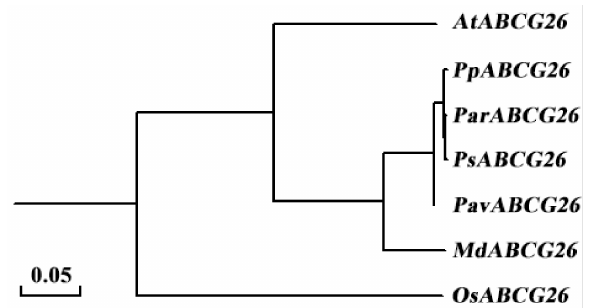
Figure 5. Phylogenetic tree of the ABCG26 proteins of different plant species. The species, from top to bottom, are Arabidopsis ( Arabidopsis thaliana ), peach ( Prunus persica ), apricot ( Prunus armeniaca ), Chinese plum ( Prunus salicina ), sweet cherry ( Prunus avium ), apple ( Malus domestica ), and rice ( Oryza sativa